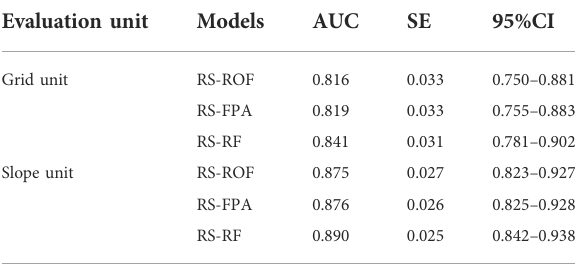
TABLE 5 Parameters of ROC curves using the training dataset.